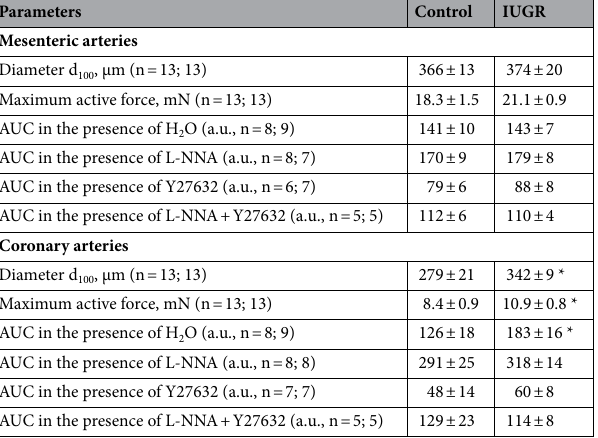
Table 2. Relaxed inner diameter (d 100 ), maximum active force and AUC for mesenteric and coronary arteries of control and IUGR rats. *p < 0.05 vs. respective value in control group (unpaired Student’s t test). Numbers in parenthesis indicate the numbers of